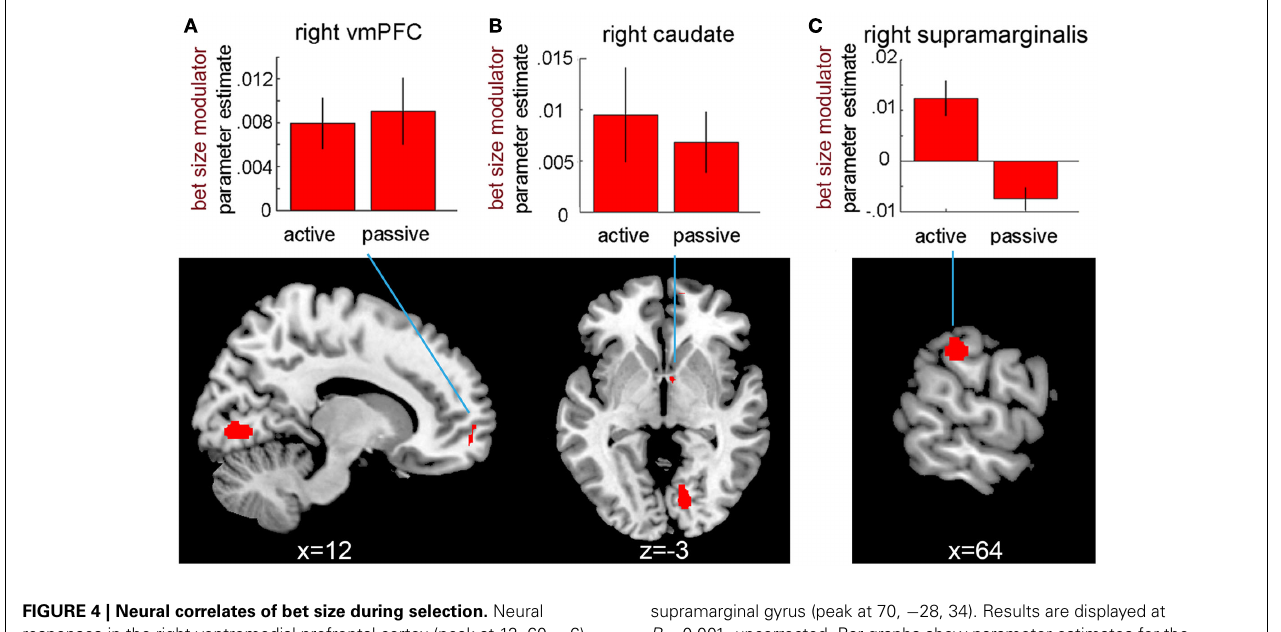
FIGURE 4 | Neural correlates of bet size during selection. Neural responses in the right ventromedial prefrontal cortex (peak at 12, 60, − 6) and caudate (peak at 6, 2, − 2) were correlated with the size of bets during both active and passive bet selection. Furthermore, a bet size × choice condition interaction was observed in the right